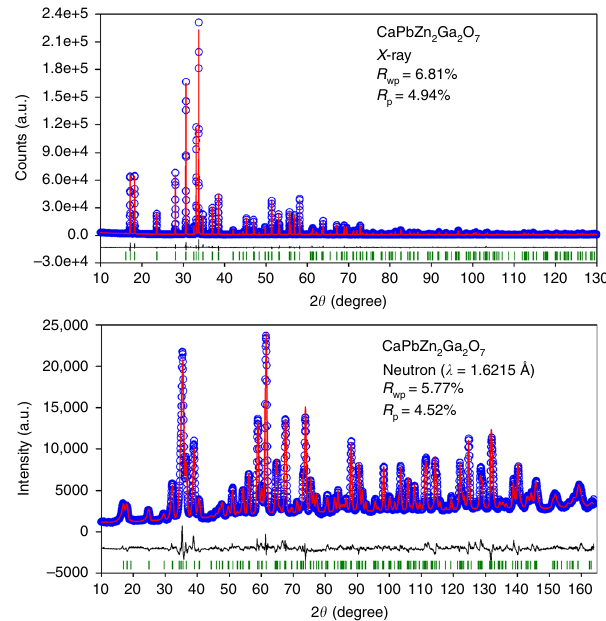
Fig. 2 Reciprocal space structure re fi nements. Combined Rietveld re fi nement plots of Cu K α 1 XRD and constant wavelength ND data for CaPbZn 2 Ga 2 O 7 re fi ned with the P 6 3 mc model. The overall reliability factors for combined Rietveld re fi nements are R wp = 6.44%, R p = 4.77%. Source data are provided as a Source Data fi